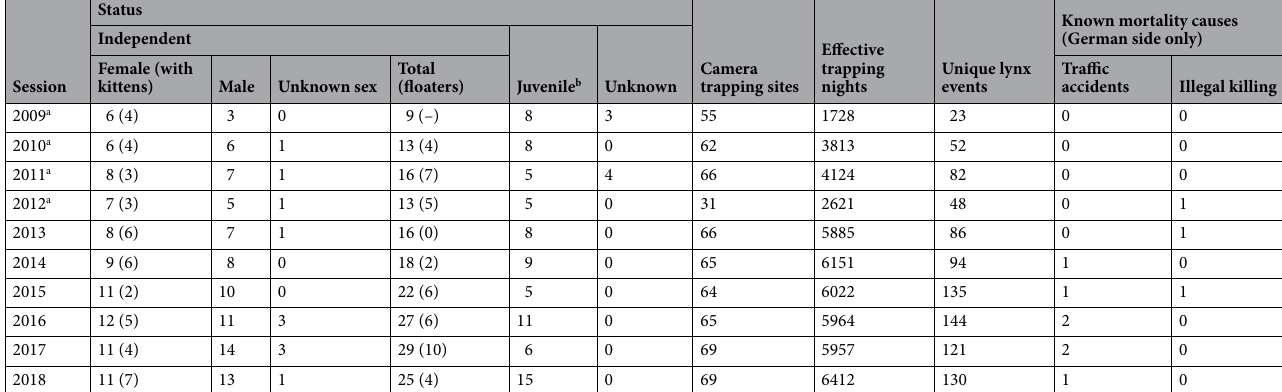
Table 1. Summary of the lynx information obtained every primary period, including: the number of independent females and resident reproducing females (with kittens), males, individuals of unknown sex, total number of independent individuals including floaters (– indicates not available), juveniles, individuals of unknown status, camera trapping sites, effective trapping nights, unique lynx events (at most one detection per site in any secondary period) of independent individuals and documented mortality cases with known causes. a The first three sessions had reduced number of effective trap nights because the monitoring started later in November in both the national parks in year 2009 and just in the SNP in years 2010 and 2011. For the session 2012, due to technical reasons, lynx camera trapping only took place on the German side of the study area. b The number of juveniles referred to the entire lynx